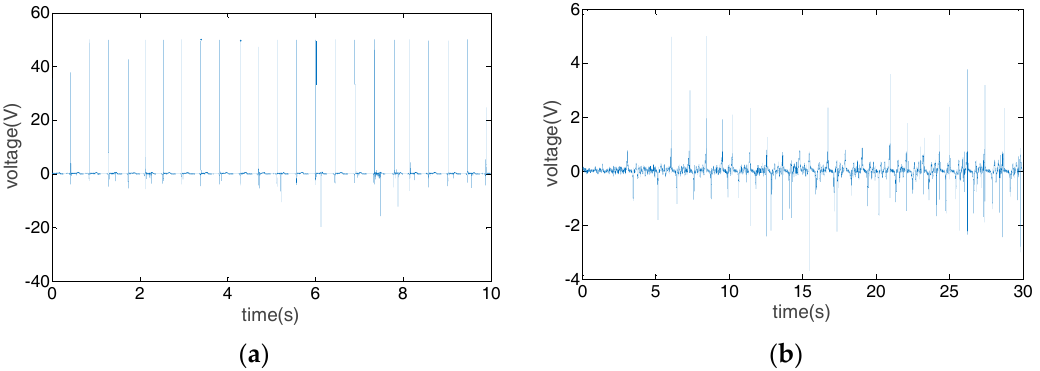
Figure 6. Performance of the harvester during ( a ) contact-separation motion and ( b ) sliding motion.